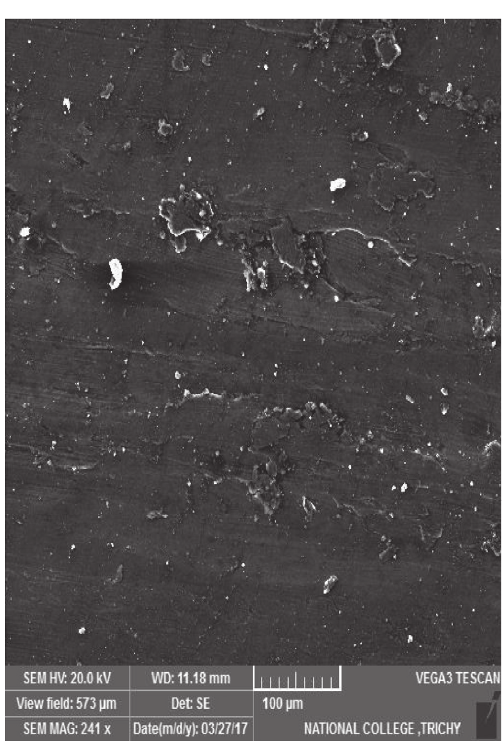
Figure 10: SEM image of Al7075 95% and TiB